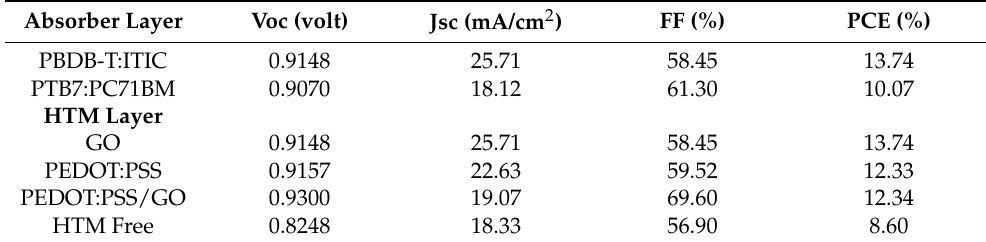
Table 3. Device performance with different absorbers and HTM